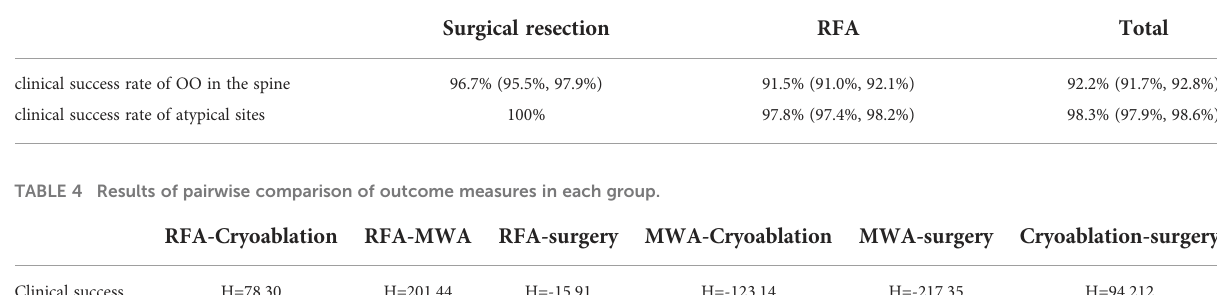
TABLE 3 The clinical success rate of OO in the atypical sites.